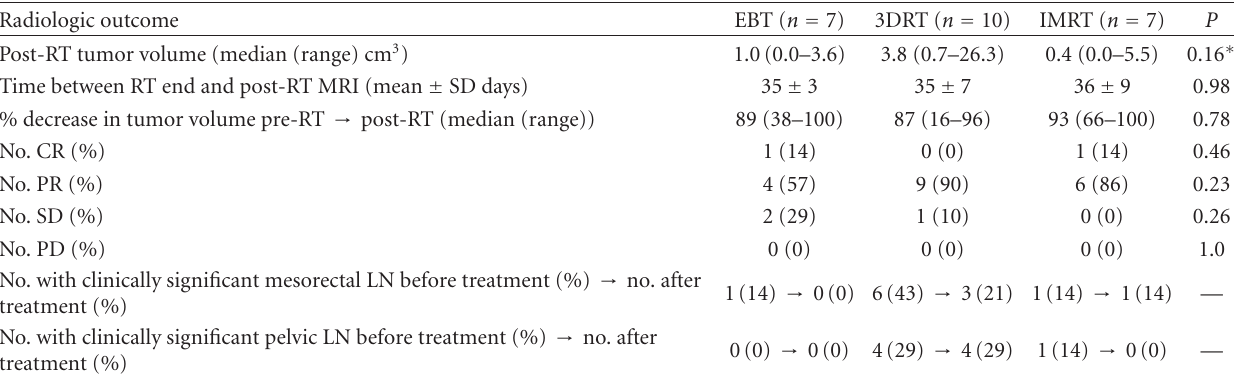
Table 3: Radiologic outcomes broken down by EBT, 3DRT, and IMRT groups with statistical comparison. EBT: endorectal brachytherapy; 3DRT: 3D conformal radiotherapy; IMRT: intensity-modulated radiotherapy; RT: radiotherapy; CR: complete response; PR: partial response; SD: stable disease; PD: progressive disease; LN: lymph